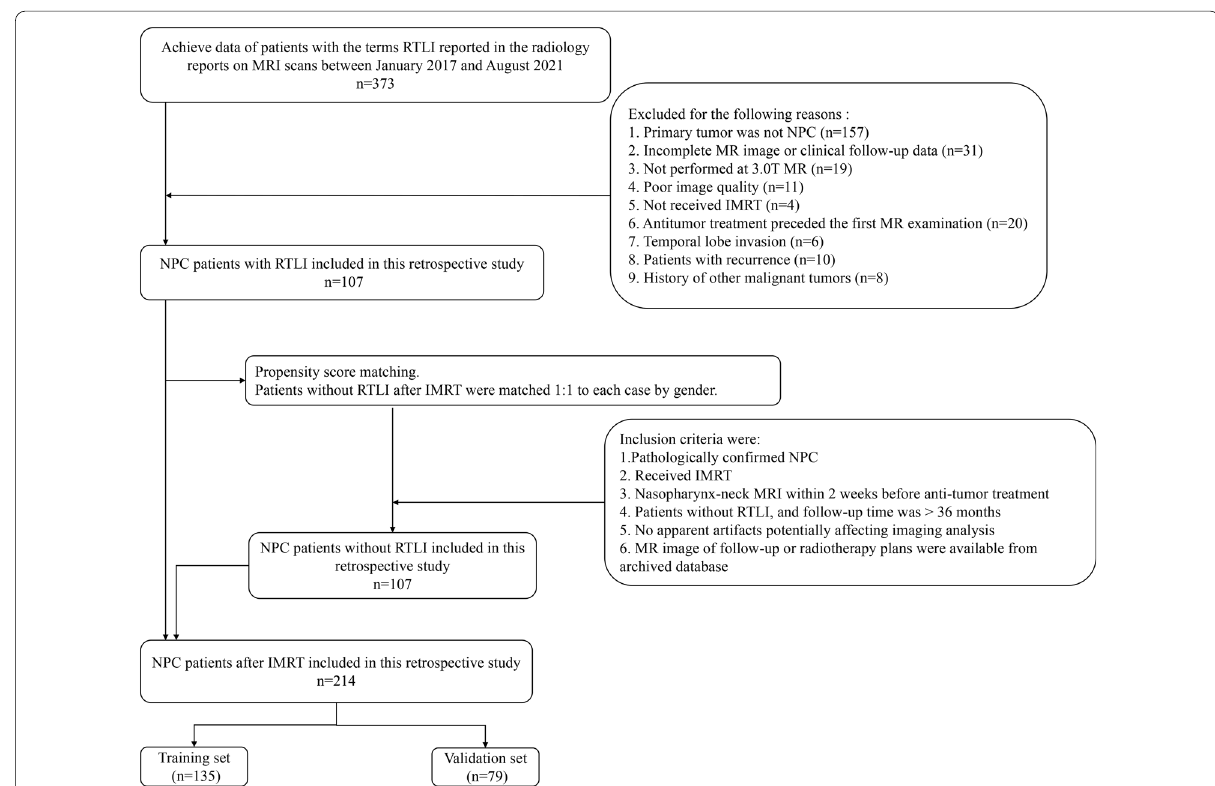
Fig. 1 Diagram for inclusion of patients into the study. IMRT RTLI radiation-induced temporal lobe =